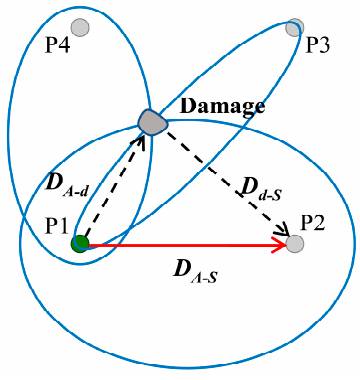
Figure 2. Ellipse positioning method.